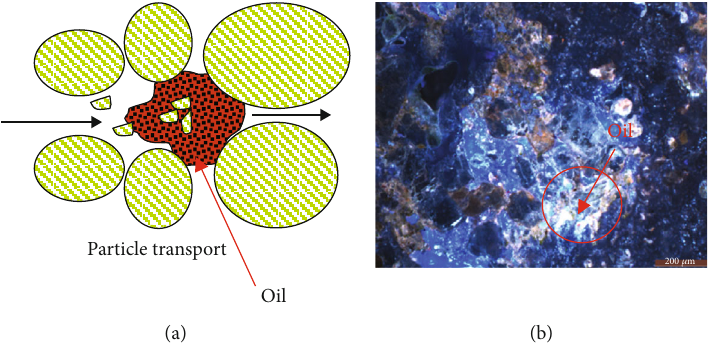
Figure 21: Causes for residual oil generation via particle migration. (a) Schematic. (b) Fluorescent